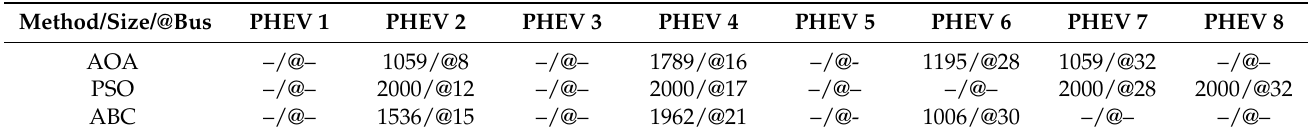
Table 6. Size and installation location of PHEVs in 33-bus distribution network using different methods.